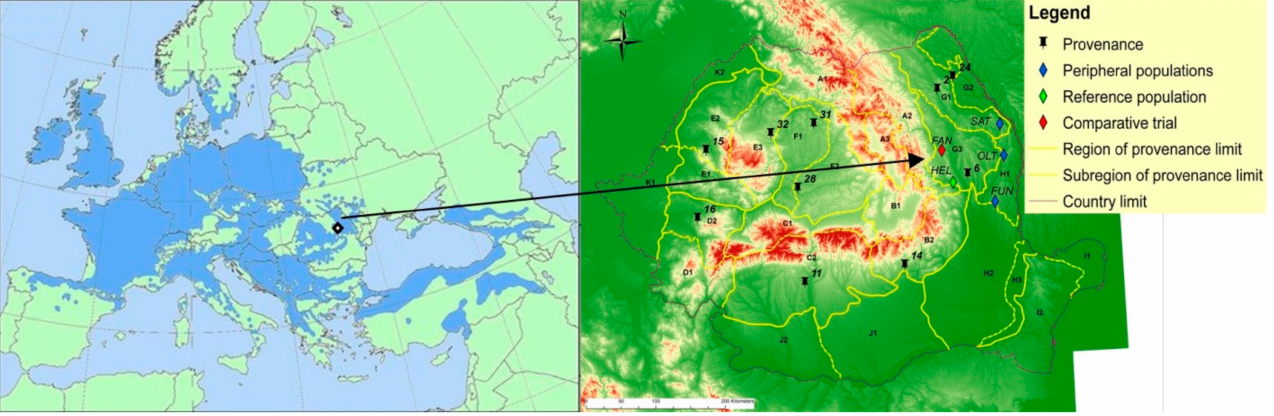
Figure 1. The natural range of sessile oak [60] ( left ), the location of the research area, and the geographic location of the origins according to the ecological subregions (A1 Eastern Carpathians– Weastern range, A2 Eastern Carpathians–Eastern range, A3 Eastern Carpathians: Giurgiu-Ciuc Depression, B1 Curved Carpathians–Brasov Depression, B2 Curved Carpathians-Exterior range, C1 Meridional Carpathians–Northern range, C2 Meridional Carpathians–Southern range, D1 Banat Mountains: Mehedinti-Cerna-Semeniuc, D2 Banat Mountains: Tarcu-Poiana Rusca, E1 Apuseni